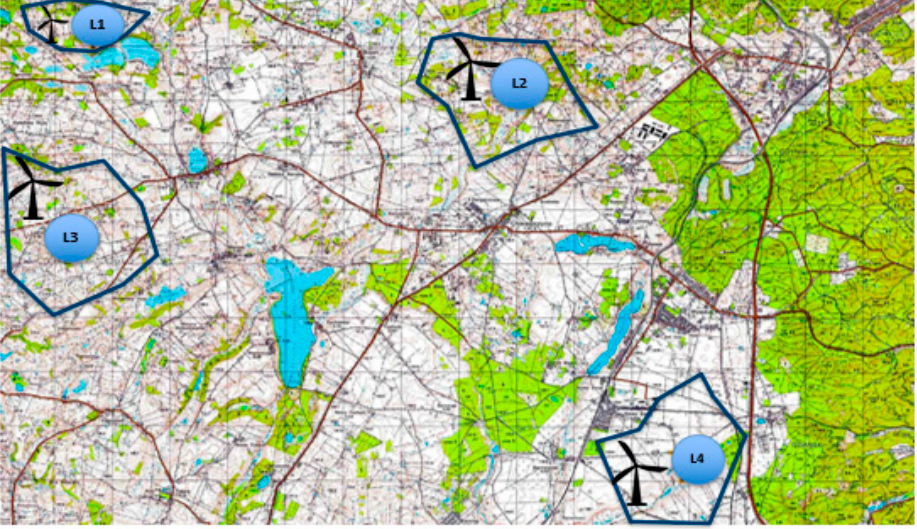
Figure 4. Map of the location of potential wind power plants.